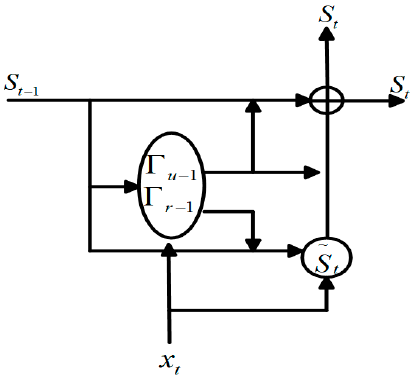
Figure 3. Basic gated recurrent units structure.